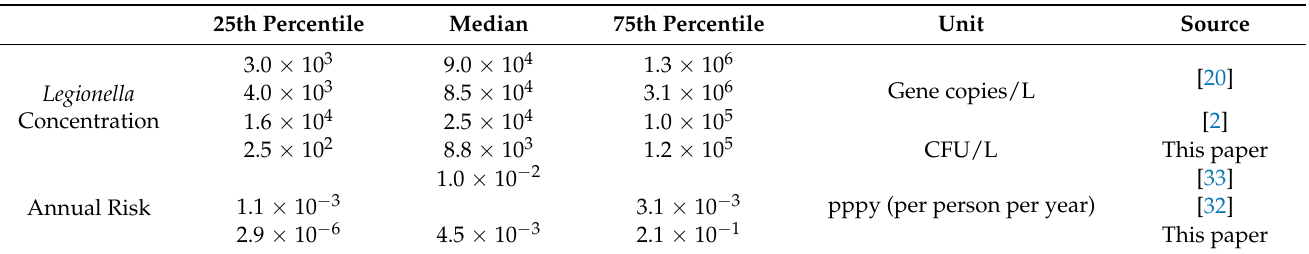
Table 2. Comparison of simulated Legionella concentrations in rain cisterns and estimated annual health risk from showering using cistern water with literature values of similar